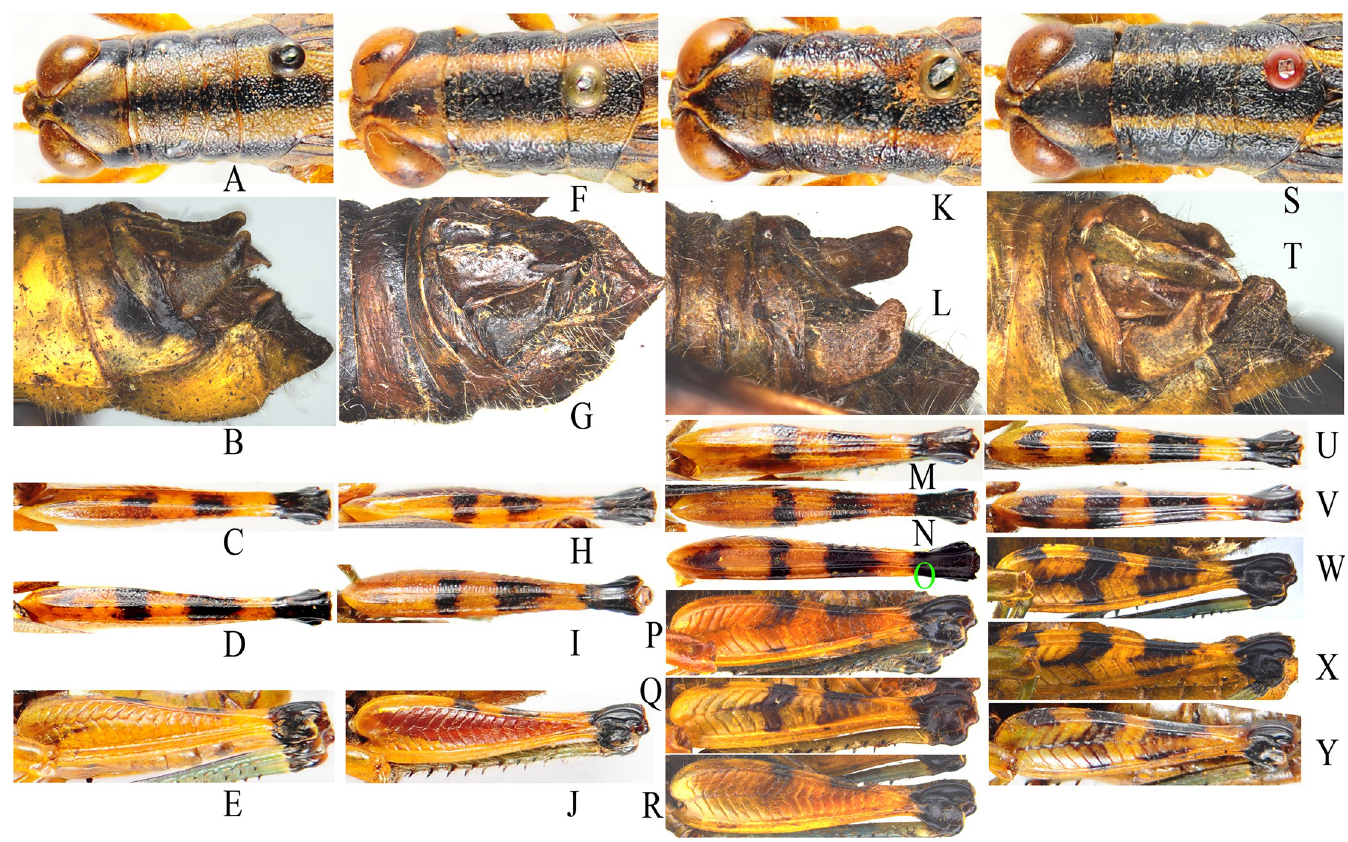
Fig 2. Pronotum, male cerci and hind femur of Tonkinacris spp . A-E. T . sinensis . F-J. T . meridionalis . K-Q. T . decoratus . R-X. T . damingshanus . A, F, K, R. Pronotum. B, G, L, S. Male cerci. C, D, H, I, M, N, T, U. Upper surface of hind femur. E, J, O–Q, V–X. External surface of hind